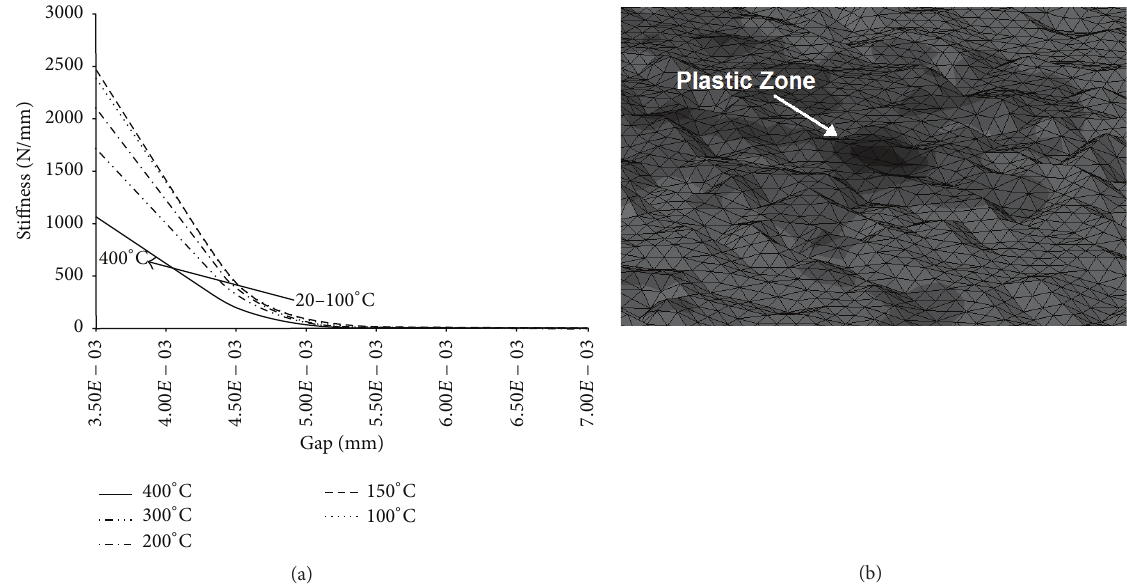
Figure 13: Contact stiffening at different temperatures (a); Von Mises stress during contact closure.